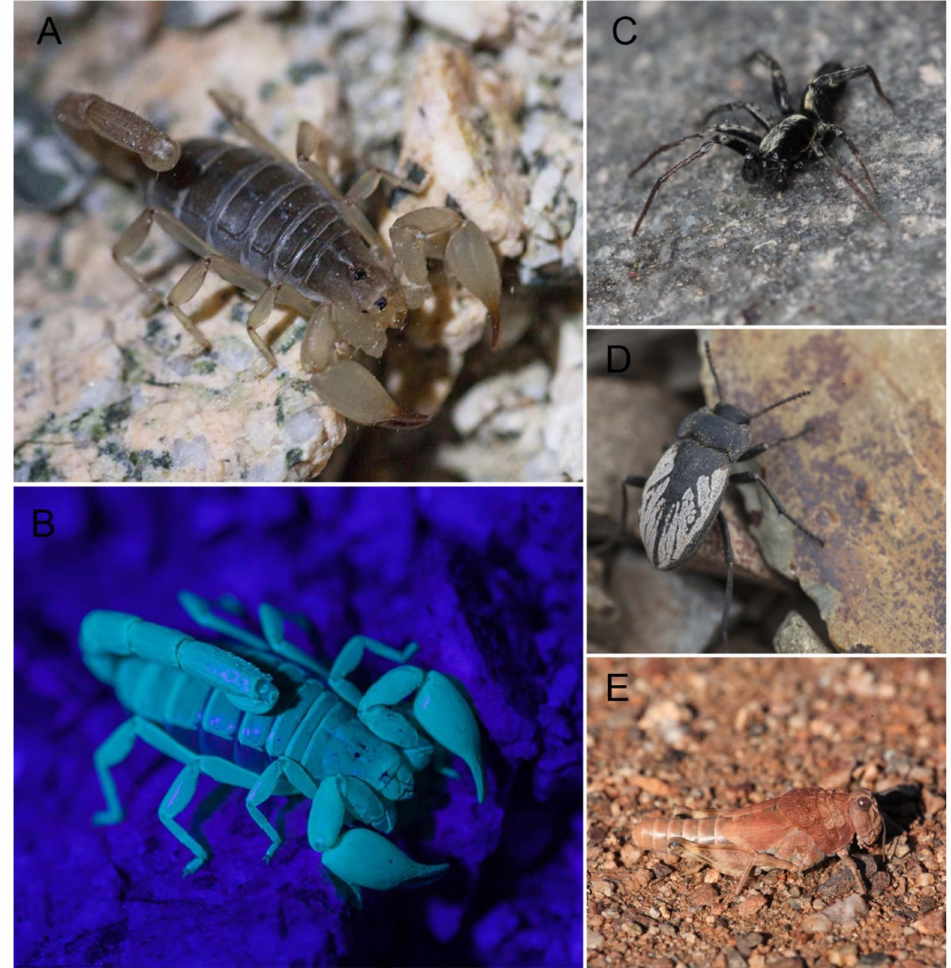
Figure 5. Different species of arthropods recorded in Paposo (Antofagasta Region, Chile). ( A ) Female of Rumikiru sp. nov. (Scorpiones: Bothriuridae) endemic of Paposo Norte Natural Monument under white light and ( B ) under UV light. ( C ) Male of Aysenia paposo Laborda, Ram í rez and Pizarro- Araya (2013) (Araneae: Anyphaenidae). ( D ) Male of Gyriosomus angustus Philippi, 1864 (Coleoptera: Tenebrionidae). ( E ) Female of Enodisomacris curtipennis Cigliano, 1989 (Orthoptera: